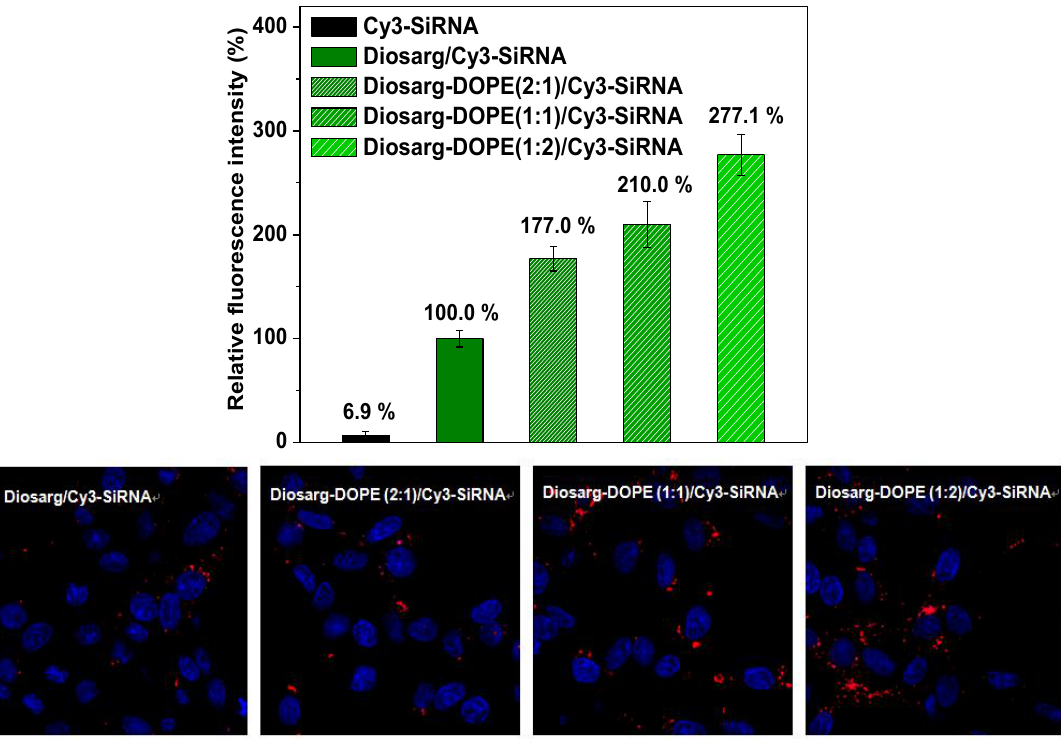
Figure 5. Intracellular uptake of the Diosarg lipid and Diosarg-DOPE (2:1, 1:1, 1:2) NPs/Cy3-siRNA complexes (+/− = 10) in H1299 cells measured by flow cytometry (10,000 cells for each sample) and observed by fluorescence microscopy (blue: DAPI (4’,6-diamidino-2-phenylindole) stained nuclei; red: Cy3-labeled siRNA).